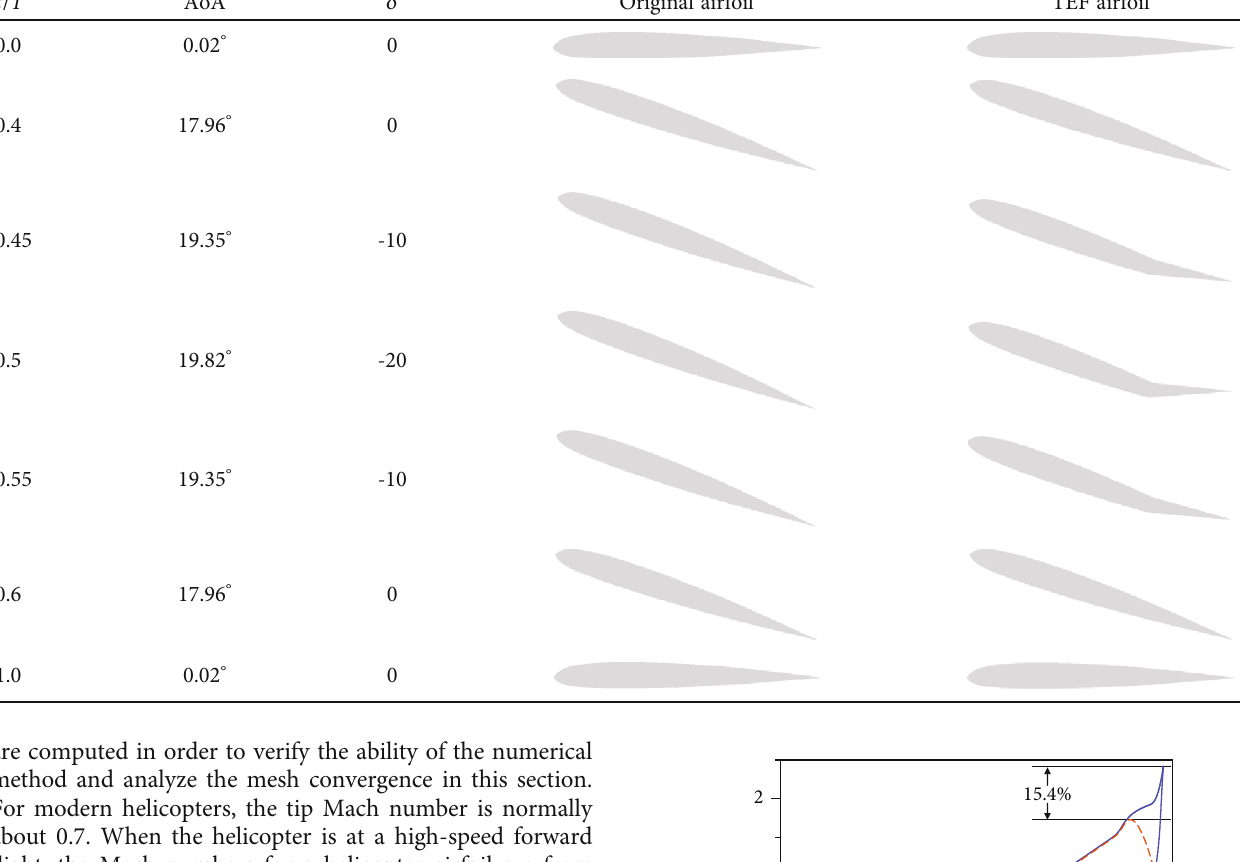
Table 2: Geometry shapes of the original and TEF airfoils at di ff erent t/T .